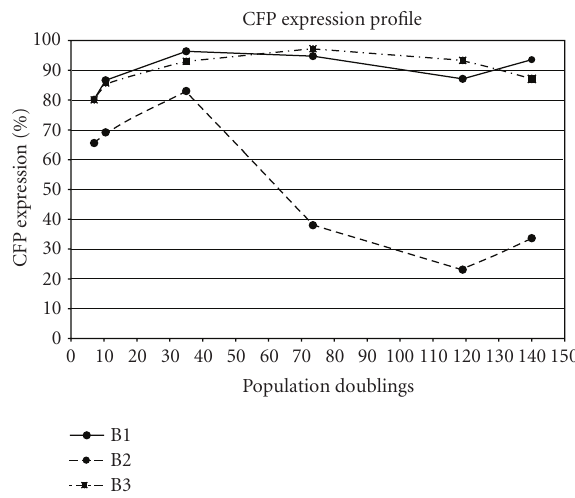
Figure 2: Stable, long-term expression of CFP fluorescence in sta- bly transfected rat hepatic ASC clones . Three cell clones expanded from CFP-transfected colonies, B1, B2, and B3 (as described in text), were propagated and serially analyzed for CFP expression. At the indicated number of population doublings, the percentage of fluorescence-expressing cells was determined by flow cytometry for each specified clone. The cells have been passaged for a maximum of 140 population